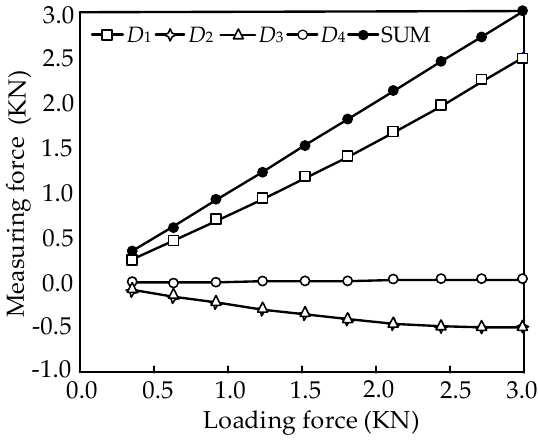
Figure 22. Calibration on the first branch.